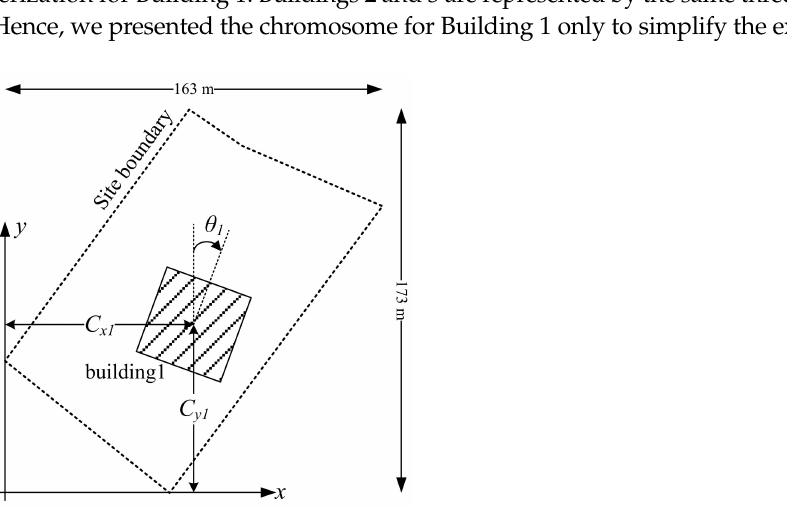
Figure 4. Design variables for configuration parameterization of Building